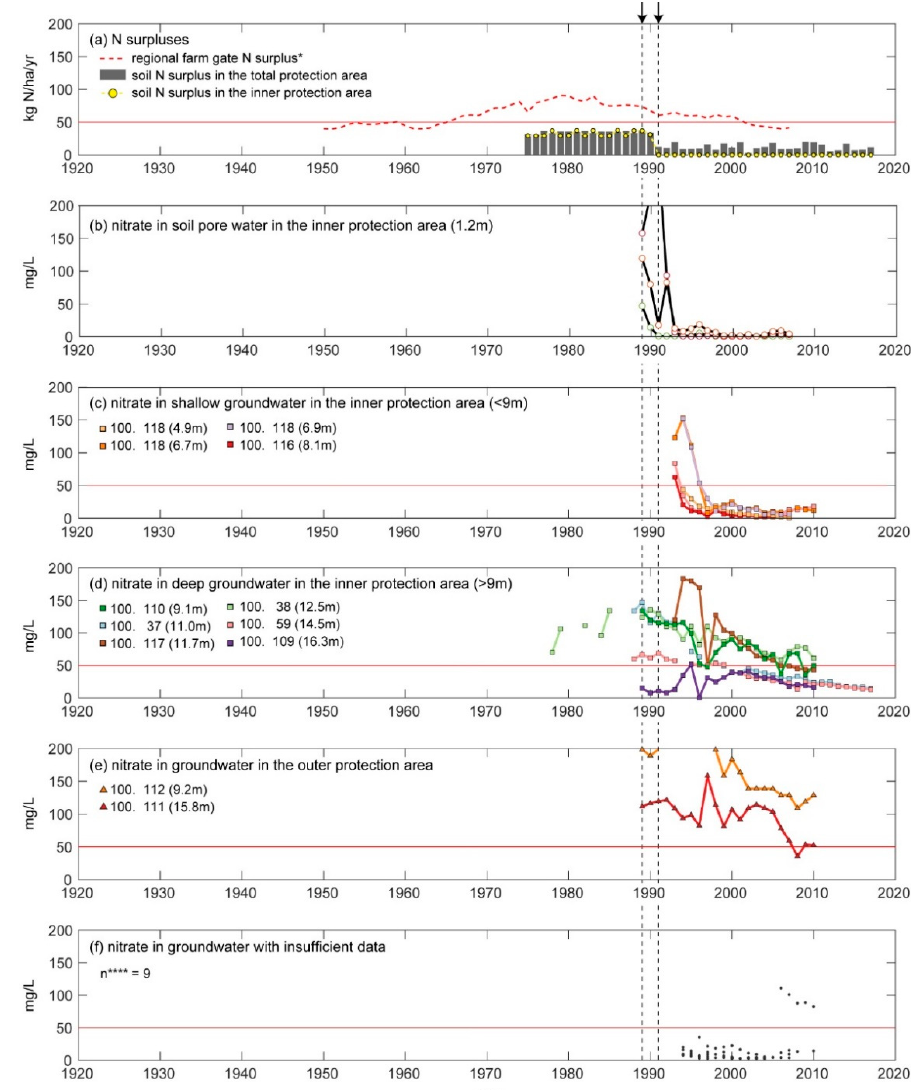
Figure 4. Overview of the nitrogen (N) surpluses and annual averages of nitrate concentrations in the soil pore water and groundwater of Tunø Island, Denmark. ( a ) The soil surface N surplus at the field level of the inner protection area and in the total protection area are shown in yellow circles and gray bars, respectively. The black arrows and dotted vertical lines show the years that the mitigation measures were implemented. The horizontal red line is the drinking water standard for nitrate (50 mg/L). The annual average concentrations of nitrate in soil pore water (circles), shallow groundwater (squares), and deep groundwater (squares) in the inner action area are shown in ( b – d ), respectively. Those of groundwater in the outer protection zone (triangles) are shown in ( e ). ( f ) shows the annual average nitrate concentrations of nine (**** n = 9; dots) monitoring points where the cross-correlation function (CCF) analysis could not be conducted due to either small variabilities of nitrate concentrations or an insufficient data length (* Hansen et al. [50]).